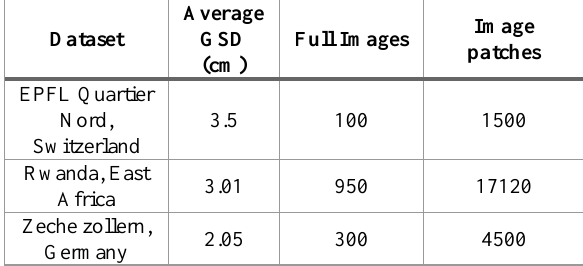
Table 1. Number of training images-stereo pairs along with extracted patches